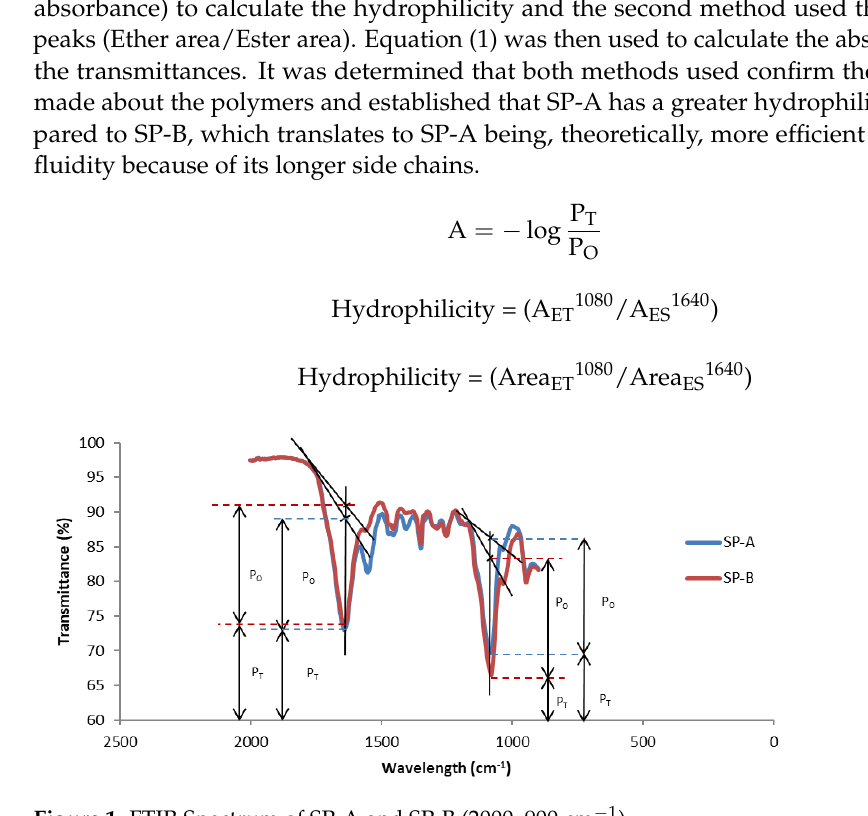
Figure 1. FTIR Spectrum of SP-A and SP-B (2000–900 cm −1 ).